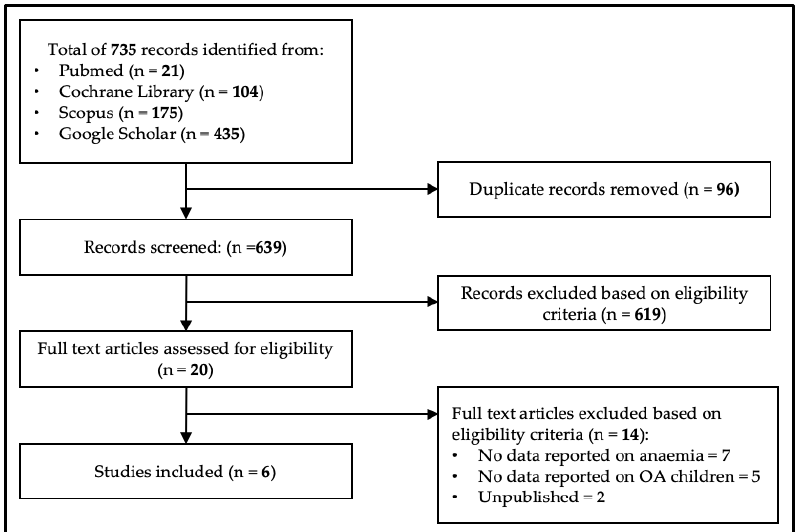
Figure 1. Prisma flow diagram.